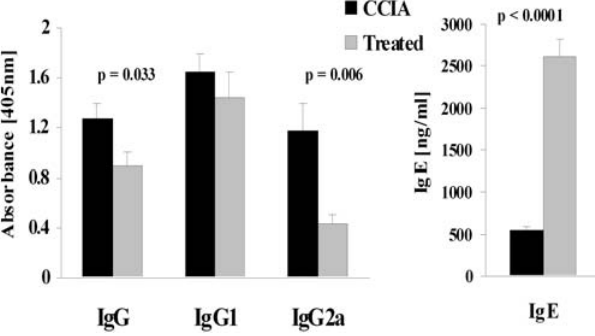
Figure 5. Epicutaneous immunization inhibits development of CII- specific IgG2a and IgG. CII-specific IgG, IgG1 and IgG2a as well as total IgE were measured in serum at the end of the experiment. Serum samples were diluted 1:1500 for IgG, IgG1 and IgG2a and 1:20 for IgE prior to analysis. Each bar represent mean antibody level + 1 SEM (n=9). ( & )=treated with epicutaneous CII, ( & )=sham-treated CCIA